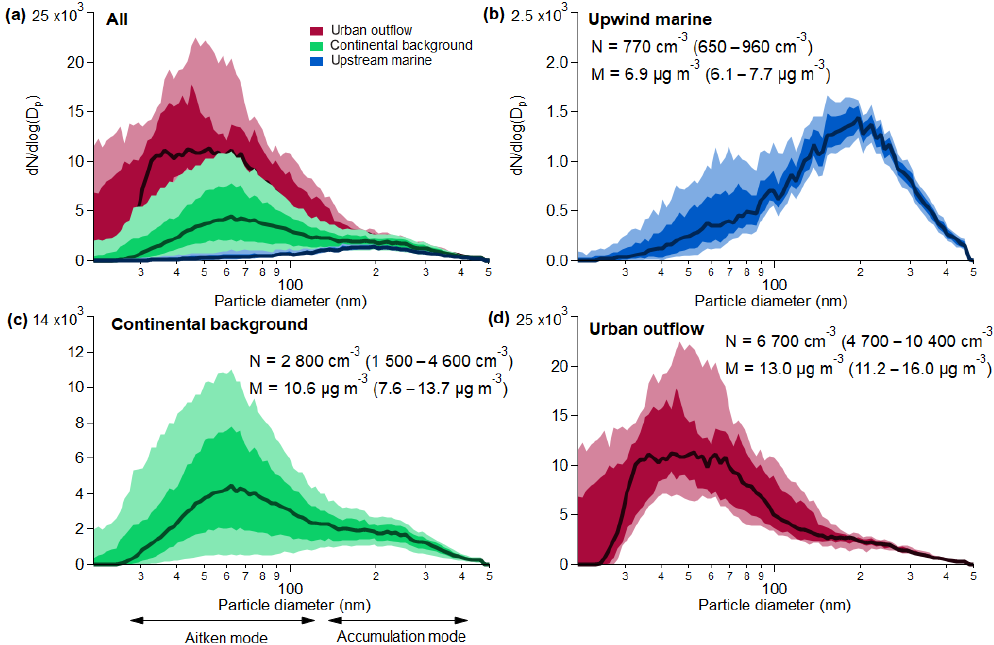
Figure 3. Size distributions of aerosol in the urban outflow, continental background and upstream marine regimes, measured by the SMPS on board the ATR aircraft. For each regime, the median size distribution is shown by the dark line, the dark shading contains 50% of the data, and the light shading contains 80% of the data. The comparison of all three plots in panel (a) shows a stable accumulation mode that exists in all three regimes, centred at around 200nm, while the smaller Aitken mode is much more variable. In panels (b) – (d) , N shows the median total number concentration summed across the whole distribution, with the lower and upper quartiles shown in brackets; M shows the calculated aerosol mass, assuming an aerosol density of 1.6gcm − 3 (Haslett et al., 2019), with the interquartile range again shown in brackets. The Aitken and accumulation modes are labelled in panel (c)